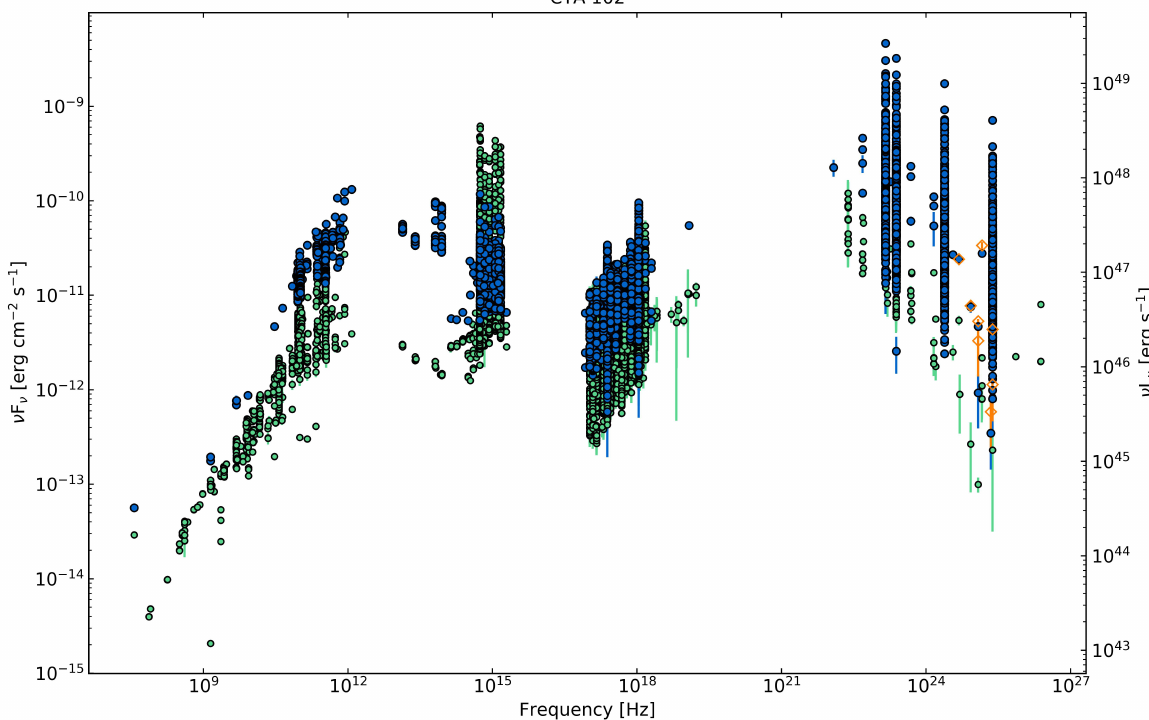
(cid:4) Fostering collaboration and